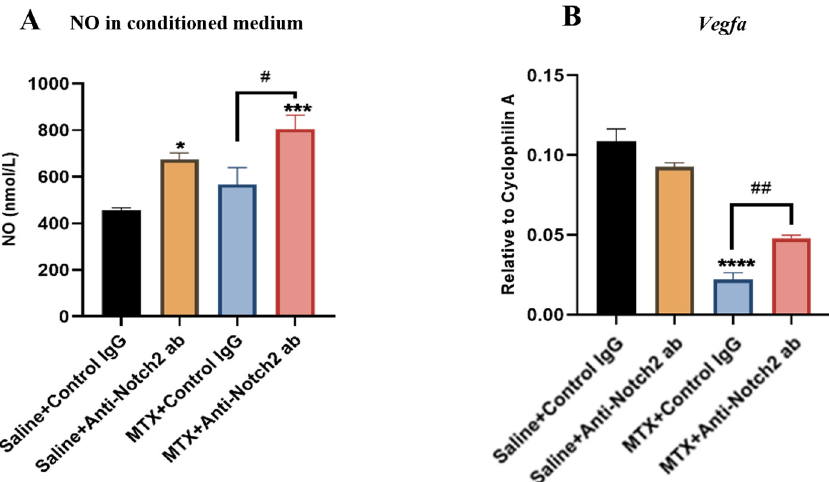
Figure 8. Treatments effect on levels of nitric oxide (NO) in conditioned medium and Vegfa mRNA expression in bone marrow-derived endothelial cells. ( A ) Levels of NO in conditioned medium from different treatment groups as evaluated by Griess assays. ( B ) Quantitative real time PCR for Vegfa mRNA expression. * p < 0.05, *** p < 0.001 and **** p < 0.0001 compared to the Saline+Control IgG group, and # p < 0.05 and ## p < 0.01 when compared between MTX treatment groups. Results shown are mean ± SEM from three independent